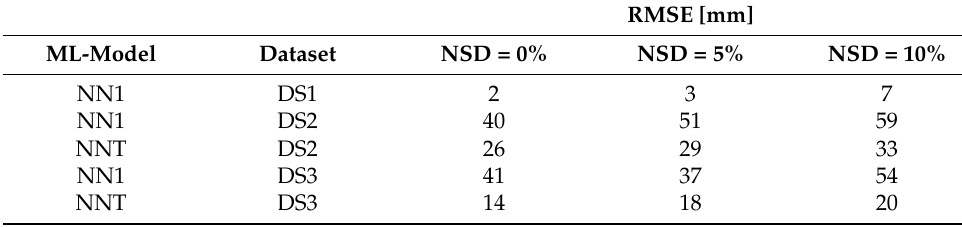
Figure 8. Prediction vs. actual tunnel displacements for DS3 with NSD = 10% computed with ( a ) NN1, i.e., no transfer learning, and ( b ) NNT, i.e., with transfer learning. Table 4. Summary of performance of ANNs under di ff erent noise standard deviations (NSD).